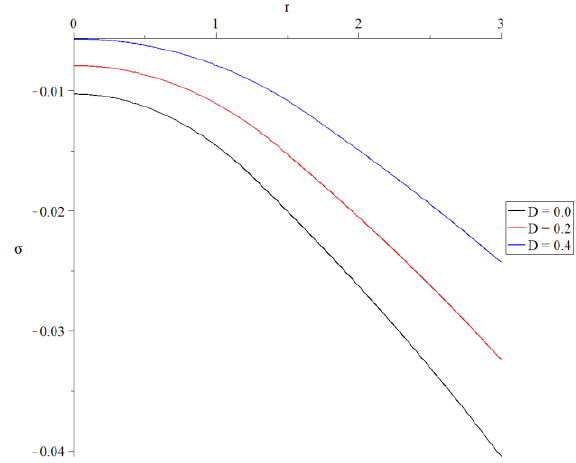
Figure 11. The distribution of the average stress for the variance values of the mechanical damage parameter in the context of the hyperbolic two-temperature model.